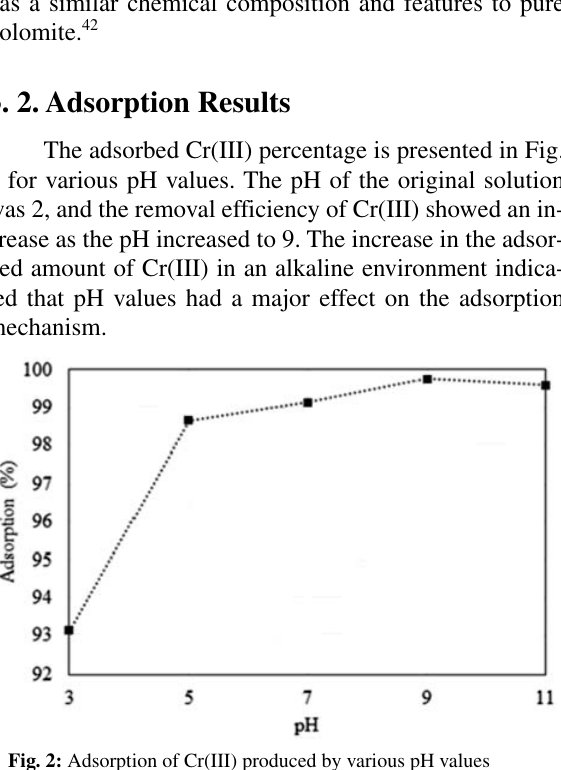
20% and 2 to be 15.986